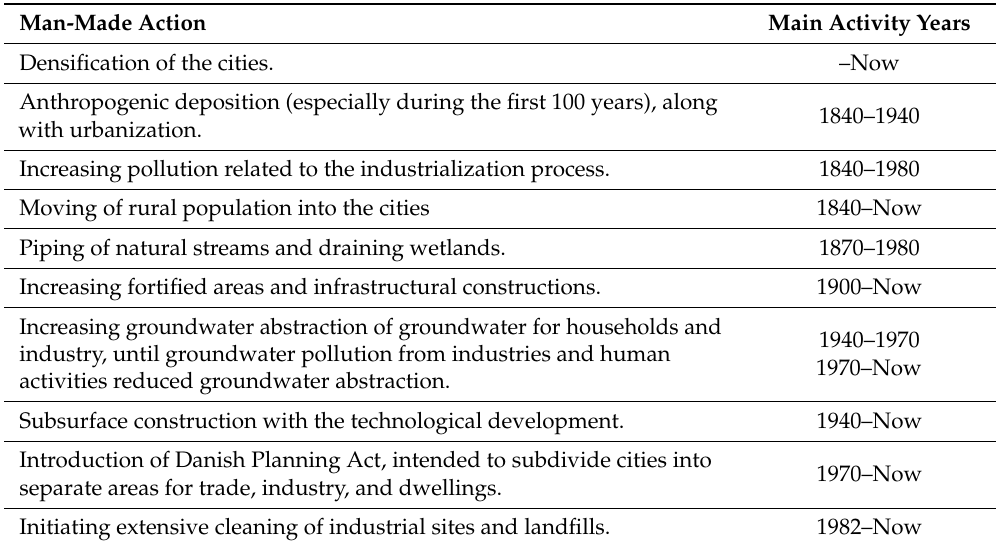
Table 3. Activities in Danish urban areas; historical evolution within the last 200 years (Compilation of the evolution of urban areas based on Cartographic maps from Odense).